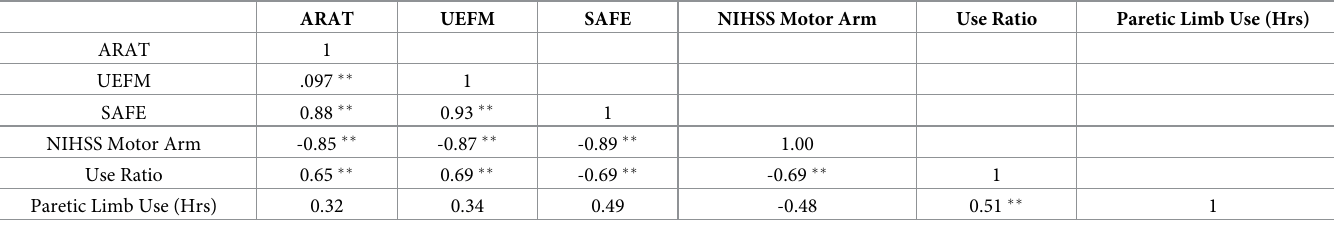
Table 3. Correlation matrix between clinical function tests and accelerometry-derived measures in Stroke group. ARAT UEFM SAFE